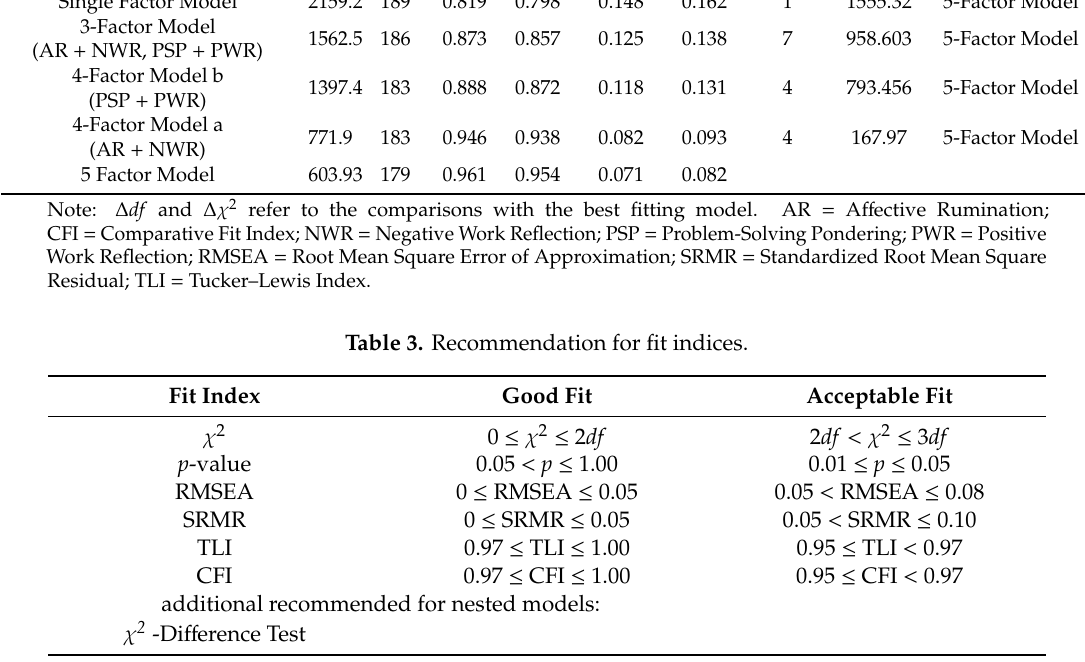
Figure 1. Focal 5-factor model and alternative models for examination of the factorial structure of work-related rumination. Table 2. Fit indices and χ 2 -difference test among alternative measurement models of the factorial structure of work-related rumination.